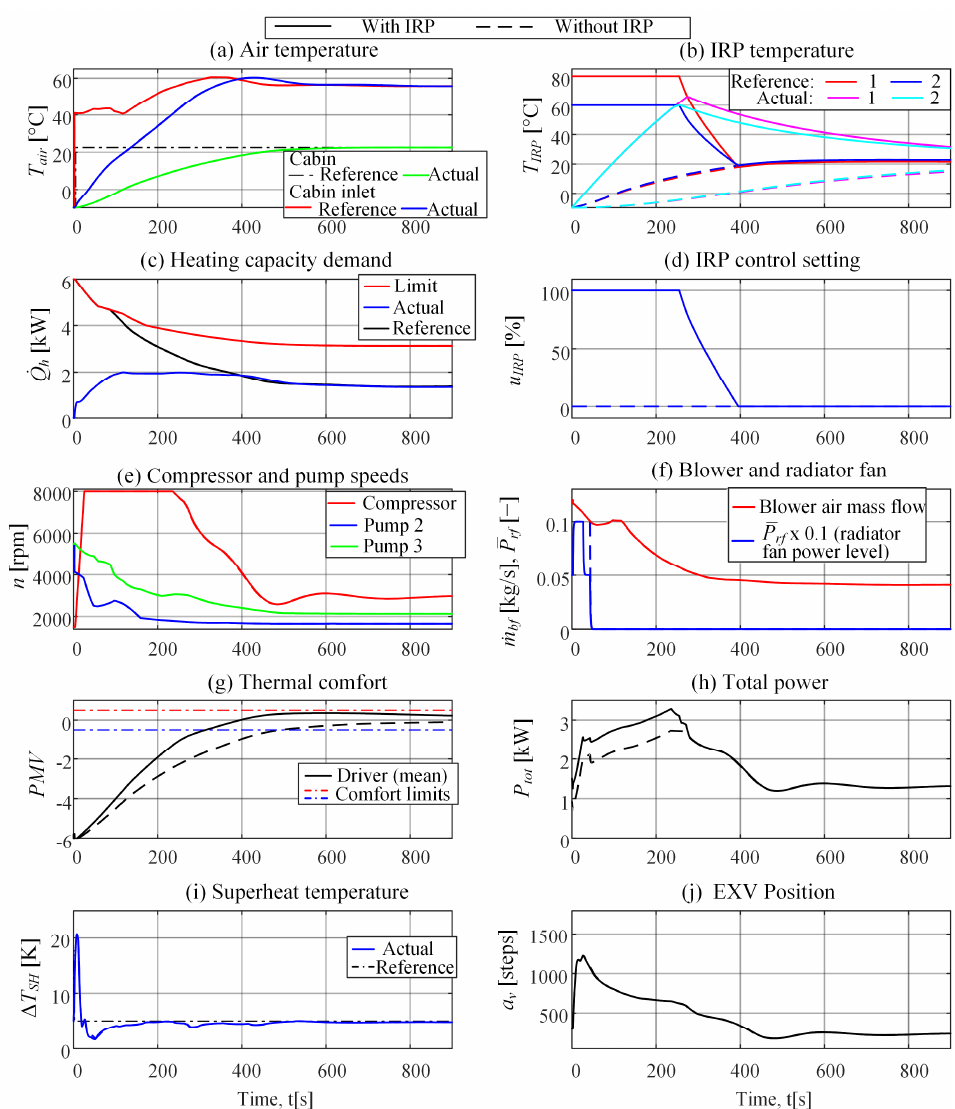
Figure 13. Comparative heat-up responses of HVAC-only system (solid line) and HVAC+IRP system (dashed line) for target cabin air temperature of 22.5 °C.